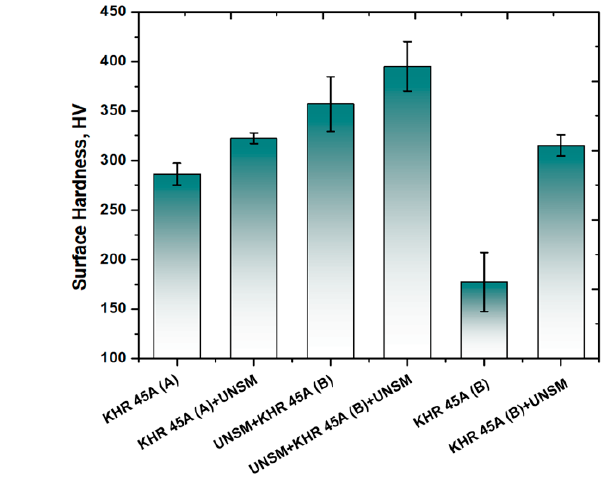
Figure 5. XRD patterns obtained from the surface of the carburized and post-carburized UNSM- treated KHR 45A steel (A).